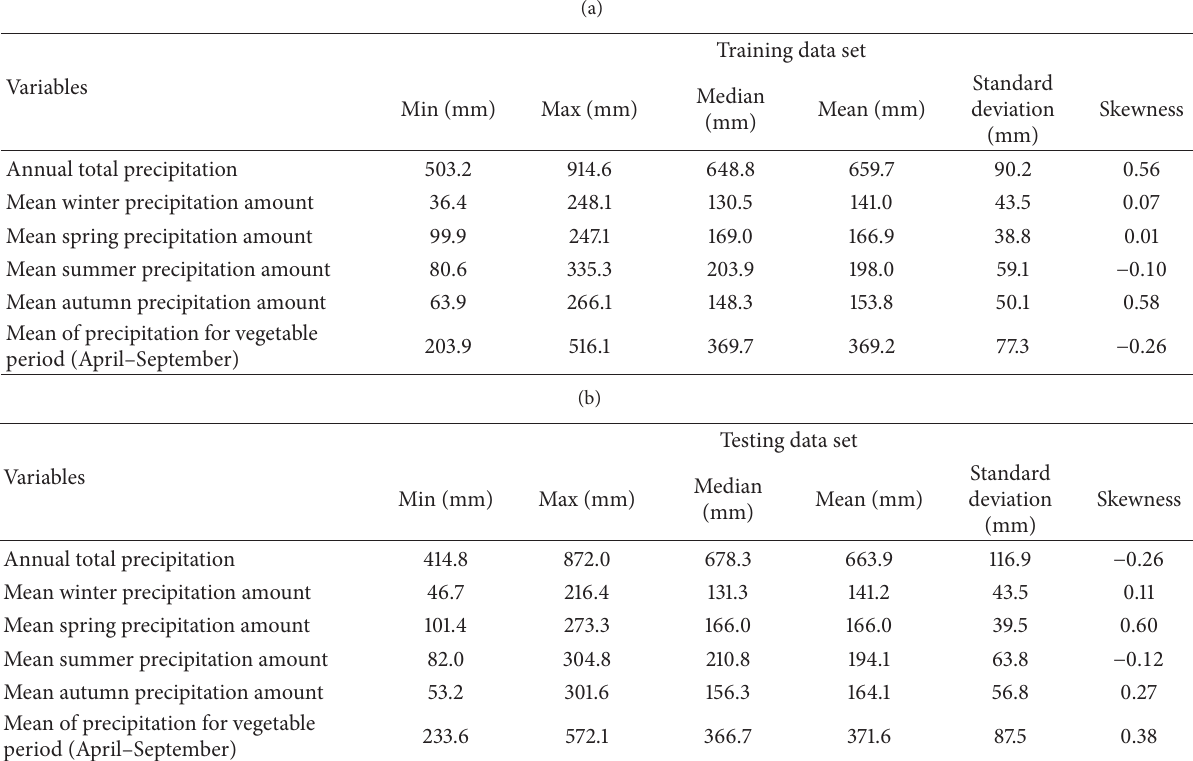
Table 3: Summary statistics for used data sets.